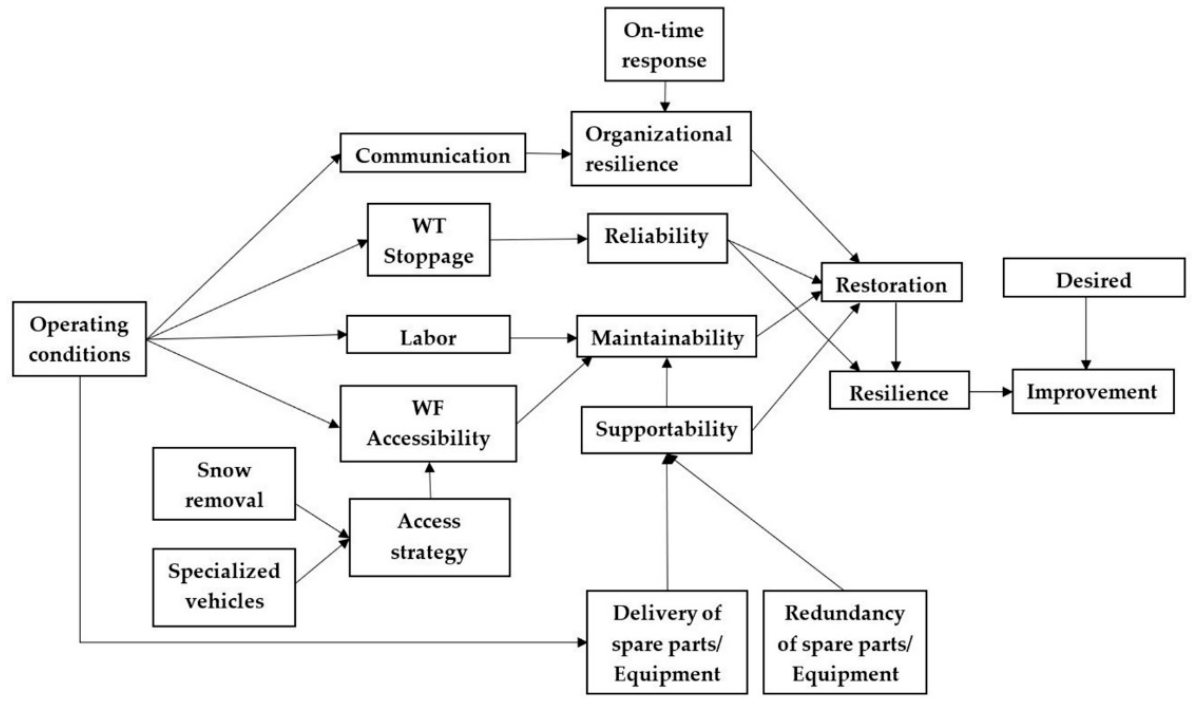
Figure 4. Graphical depiction of the proposed BN for WF resilience calculation.